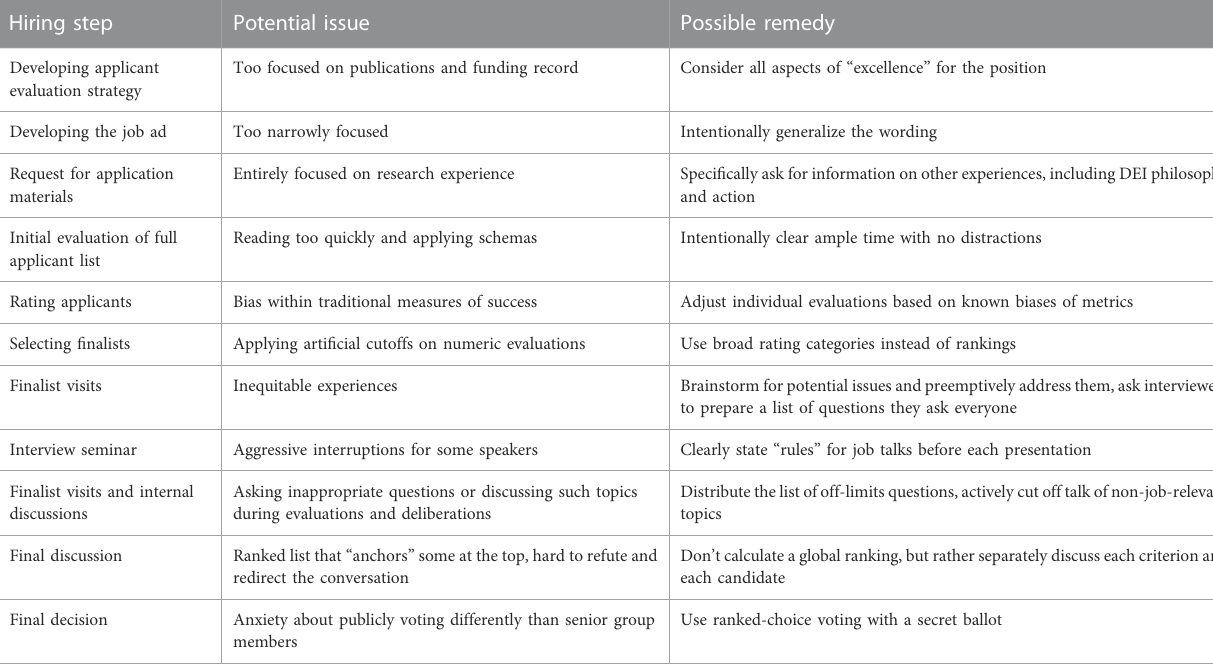
TABLE 4 Summary of suggested remedies to possible equity issues during the hiring